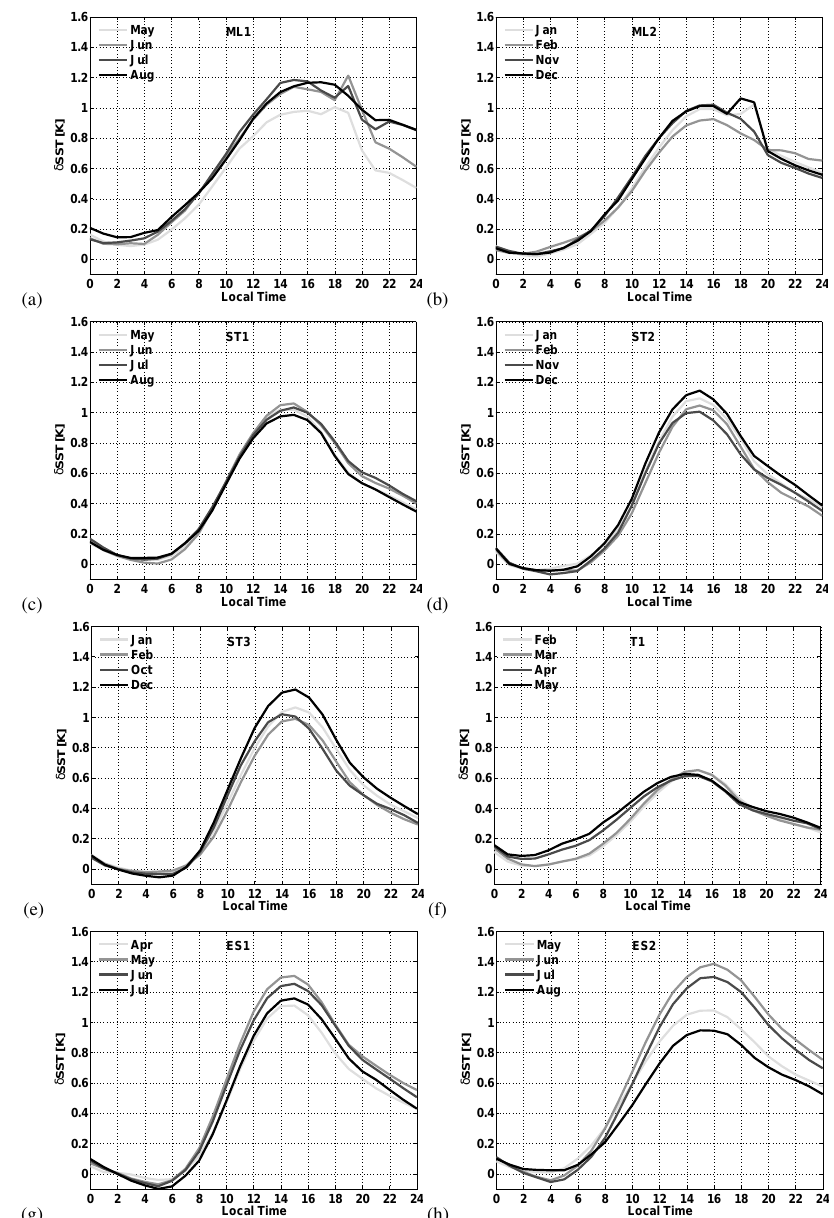
Fig. 8. Monthly-averaged daily cycles in different domains of the SEVIRI disc: (a) ML1, (b) ML2, (c) ST1, (d) ST2, (e) ST3, (f) T1, (g) ES1 and (h) ES2. In each domain, the 4 months with the highest number of recorded δ SST are shown. The daily cycle is produced by hourly averaging grid cells that show δ SST ≥ 0 . 5K at least once during the day. A zero value indicates that the monthly averaged hourly SST value is equal to the foundation temperature value. If the temperature at the end of the cycle does not approach the pre-warming value, a residual warm layer exists.